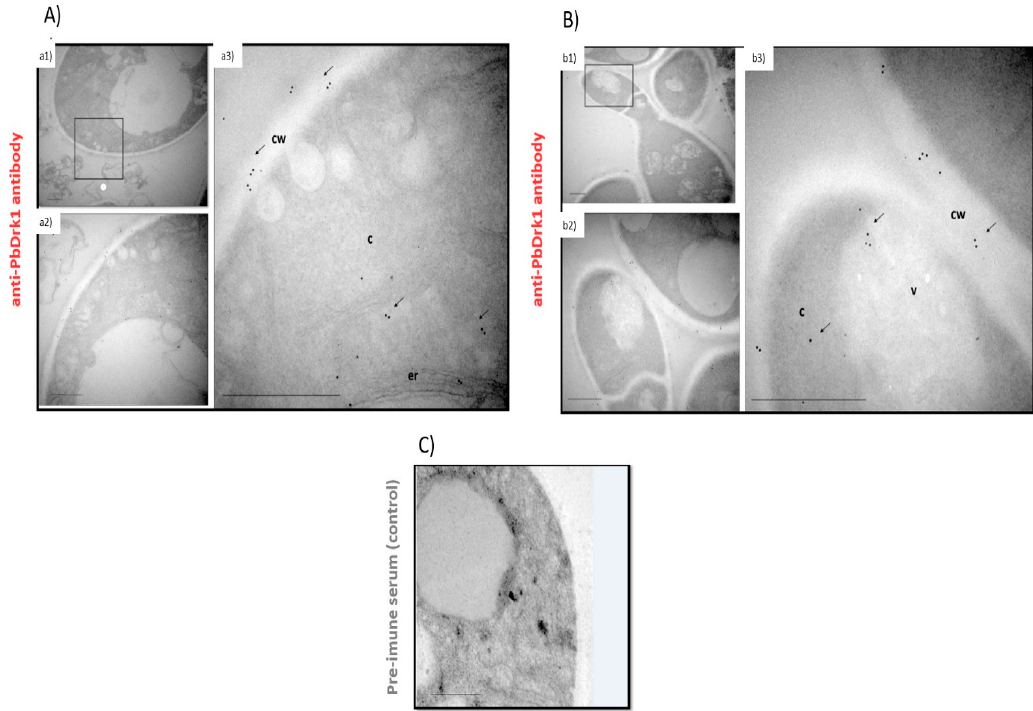
Figure 4. Immunogold analysis of PbDrk1 protein localization in P. brasiliensis yeast cells. The highlighted square in ( a1 ) and ( b1 ) points to the P. brasiliensis cell section examined in the differents microscope objectives ( a2 , a3 , b2 and b3 ). ( C ) Negative control with non-immune rabbit serum showed no labeling. Abbreviations: cw: cell wall; er: endoplasmatic reticulum; c: cytoplasm; v: vacuole. Scale bars: 1 µm. Arrows indicate PbDrk1-specific gold particles.